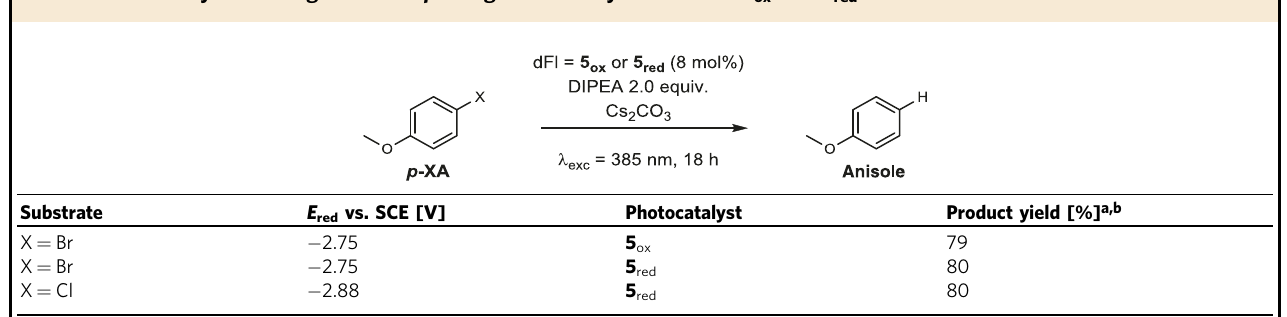
Table 1 Photocatalytic dehalogenation of p -halogenanisole by deaza fl avin 5 ox and 5 red .